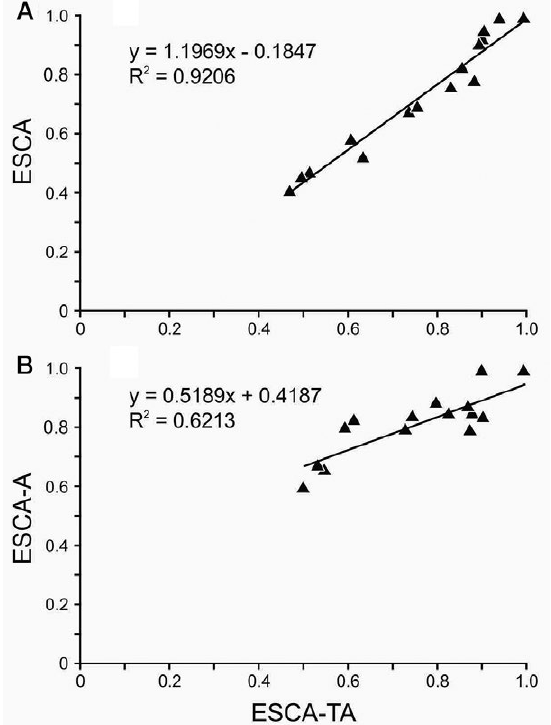
Fig. 4. – Relationships between the ESCA-TA index and the ESCA (A) and the ESCA-A (B) indices. The equations and the values of the determination coefficients (R 2 ) are reported,